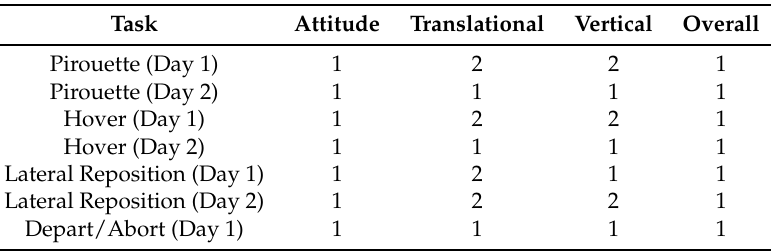
Table 2. Useable cueing environment (UCE) evaluation